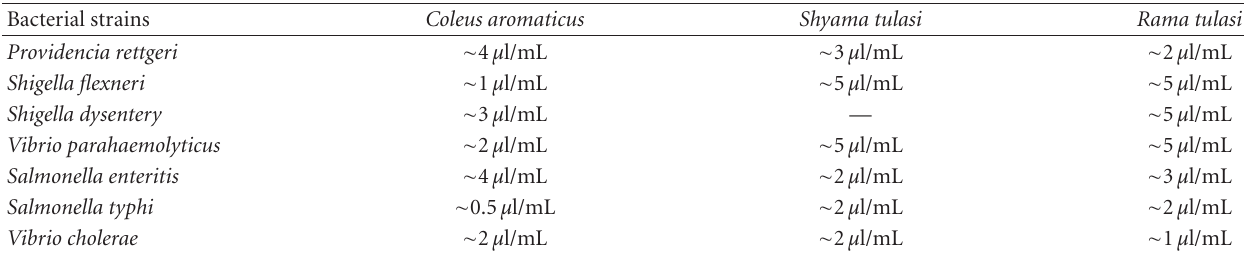
Table 1: MICs of essential oil against known pathogenic